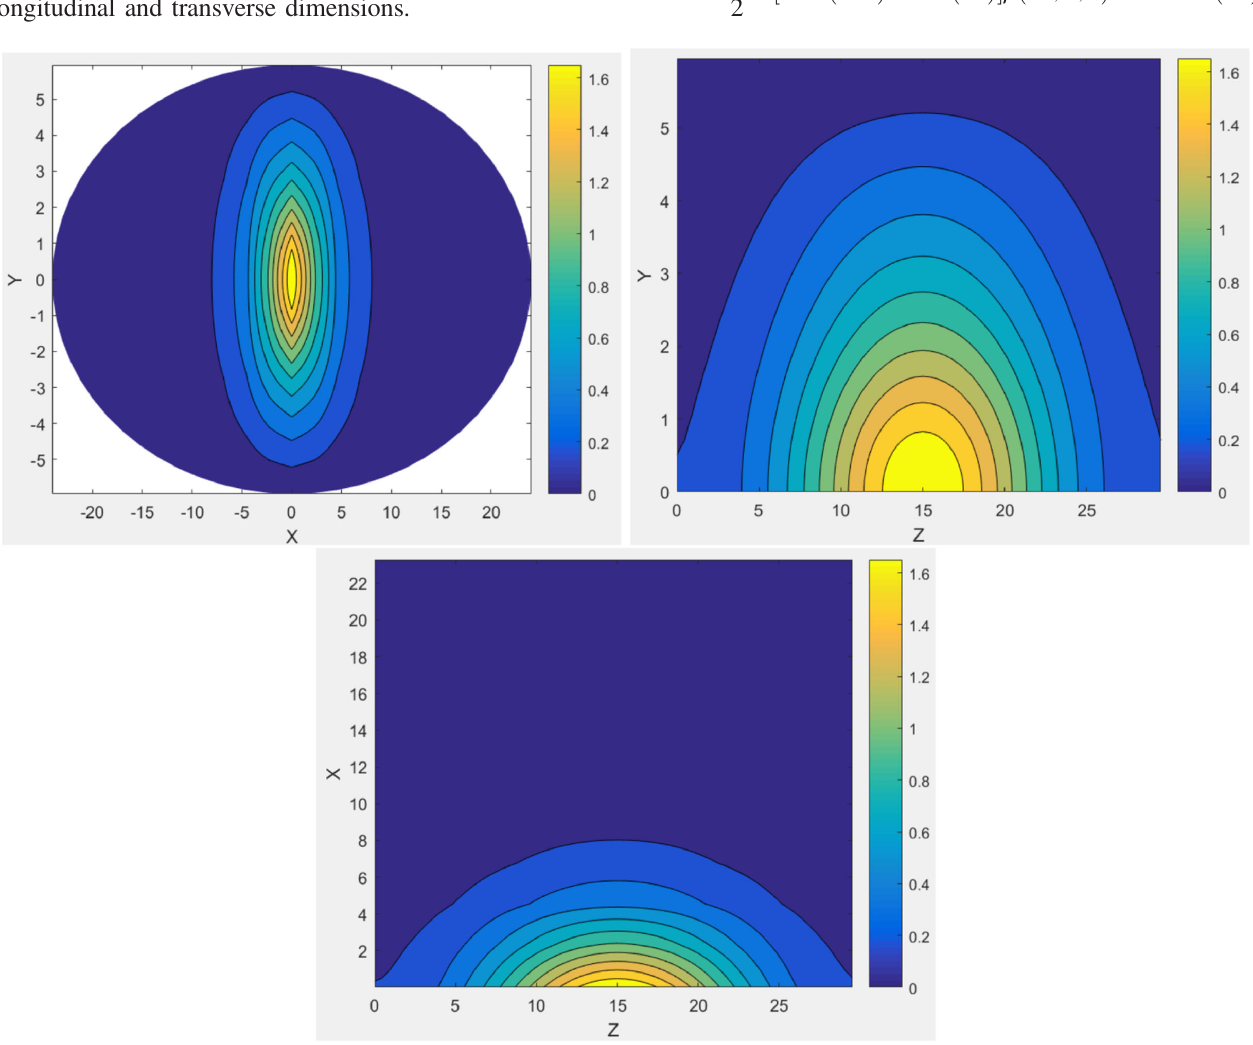
FIG. 7. The normalized electric potentials in the middle X − Y plane (upper left), the middle Z − Y plane (upper right), and the middle Z − X plane (bottom) from the spectral-finite difference method using a 3D bunched Gaussian density distribution with longitudinal periodic boundary condition and transverse elliptical conducting